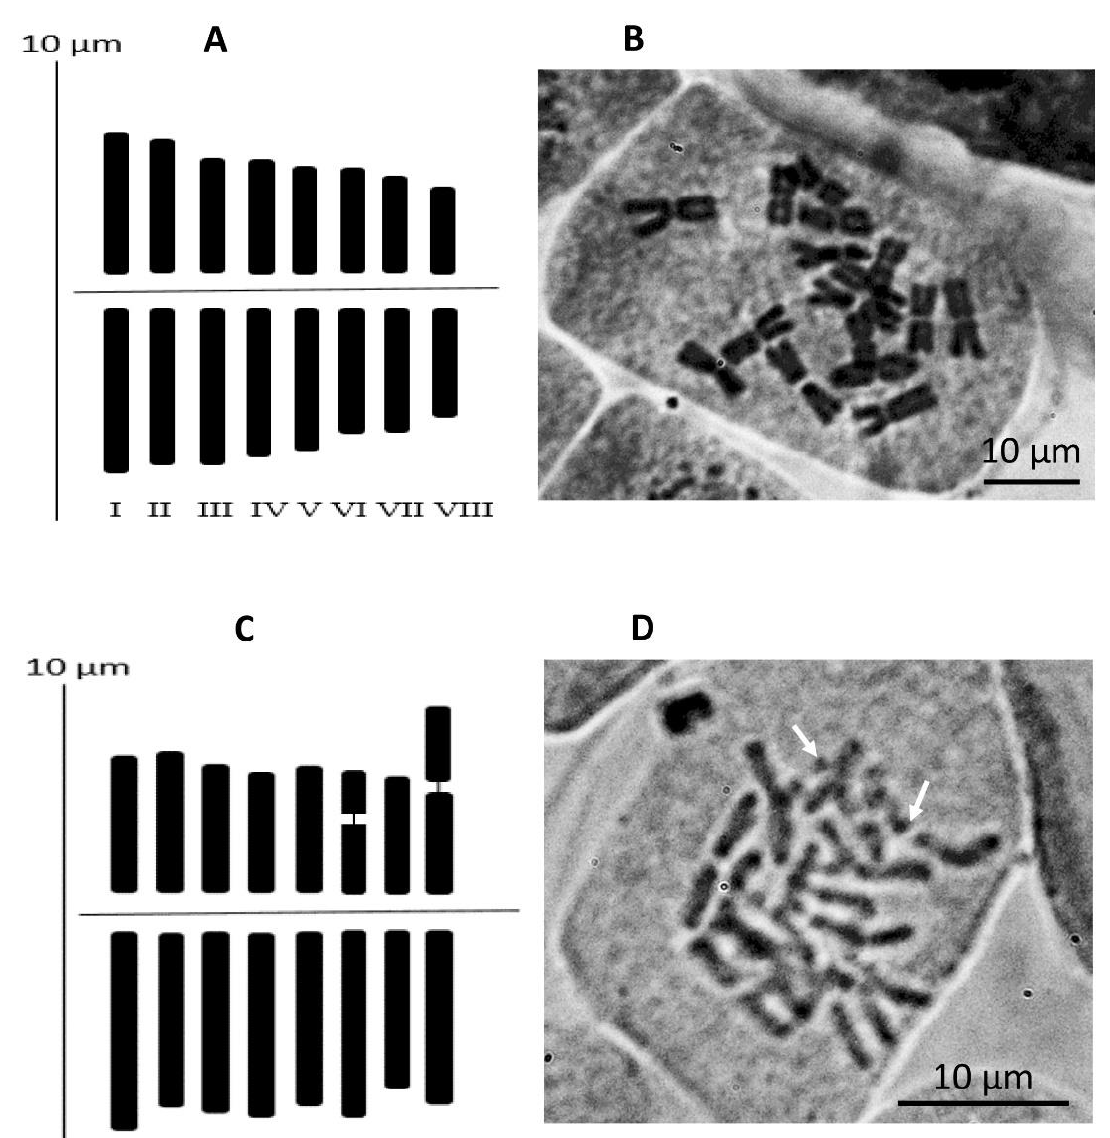
Figure 7. ( A ) — Idiogram of Allium pallasii, based on 36 metaphase plates; ( B ) — metaphase plate of Am804, ( C ) — Idiogram of A. caricifolium based on five metaphase plates; ( D ) – metaphase plate of Am1246. Arrows point to satellites. Roman numbers show the numbering of chromosome pairs Table 2. Karyo-morphometric parameters of A. pallasii accessions in µm.